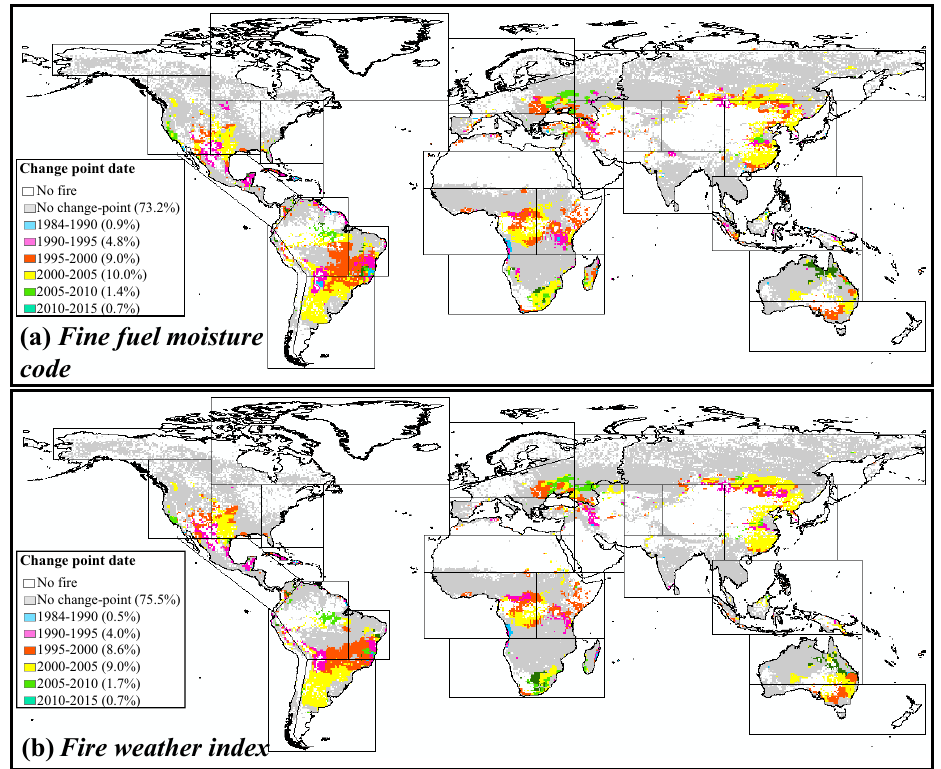
Fig. 5 Global map-3 showing the distributions of the change-points. This global map-3 shows the distributions of the change-points of the fine fuel moisture and fireweather index on a monthly scale. The map is marked with grids of significant change-points,where different colors indicate when an abrupt change occurs. Blanks in the figure indicate areaswithout wildfires. Numbers in parentheses indicate the percentage of change-point